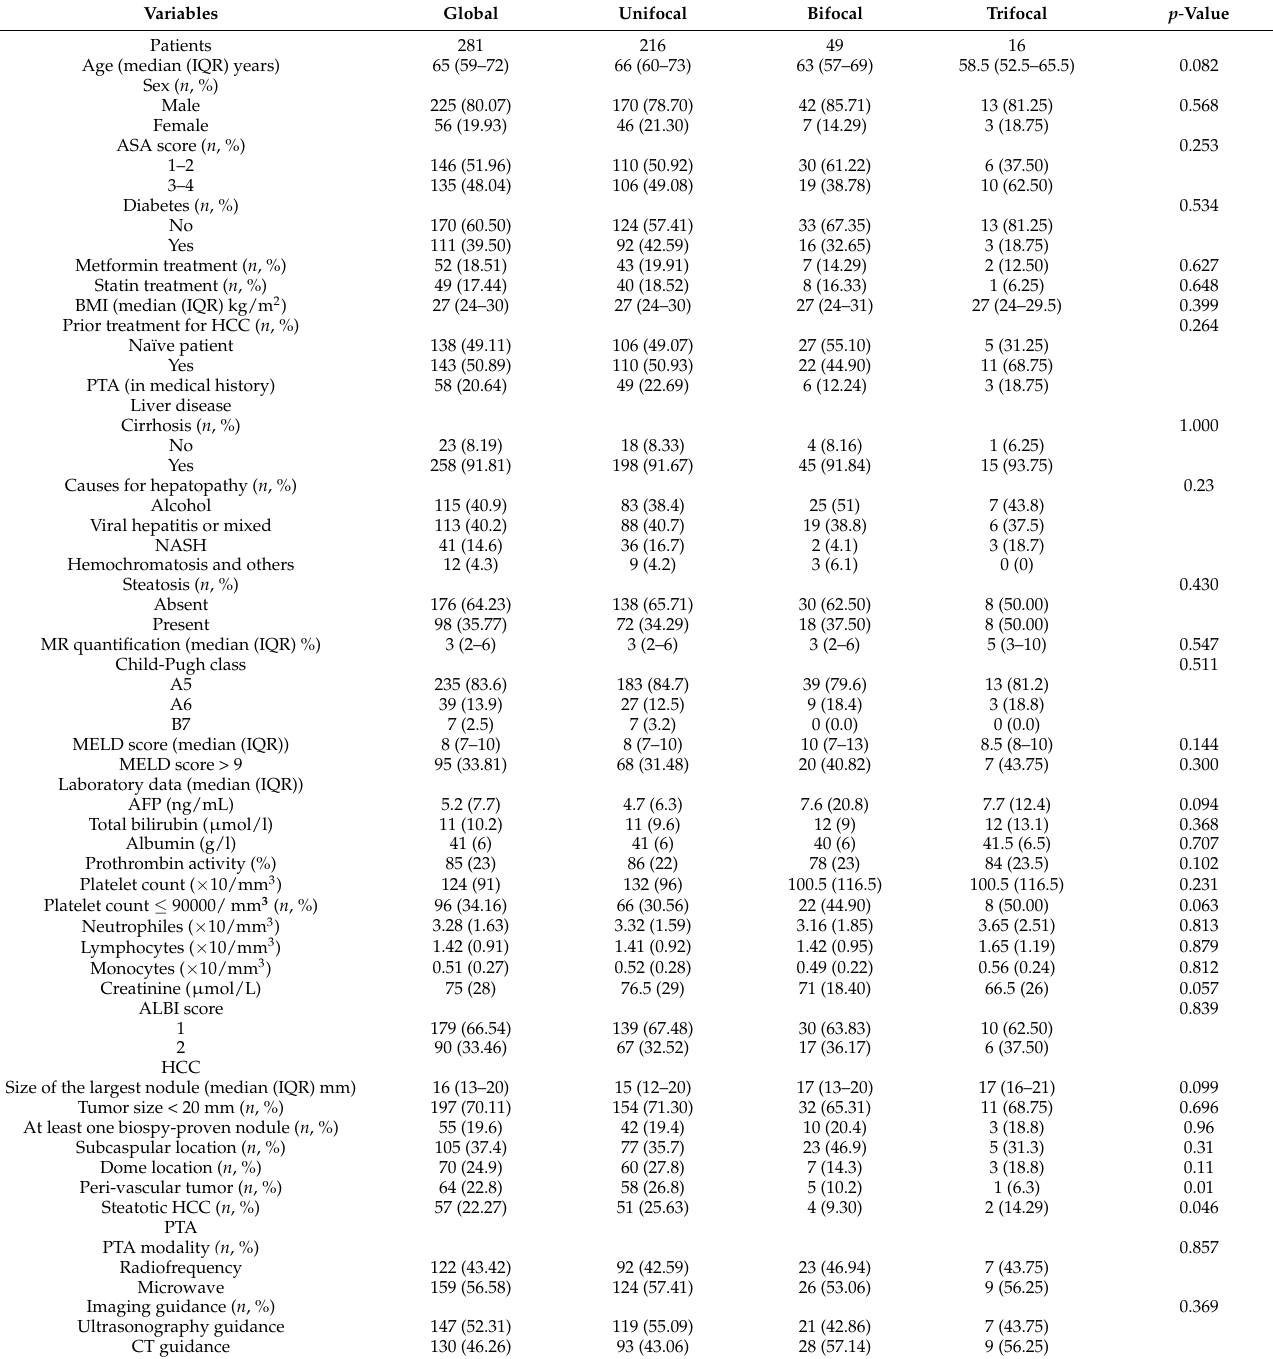
Table 1. Baseline characteristics of patients with HCC treated by